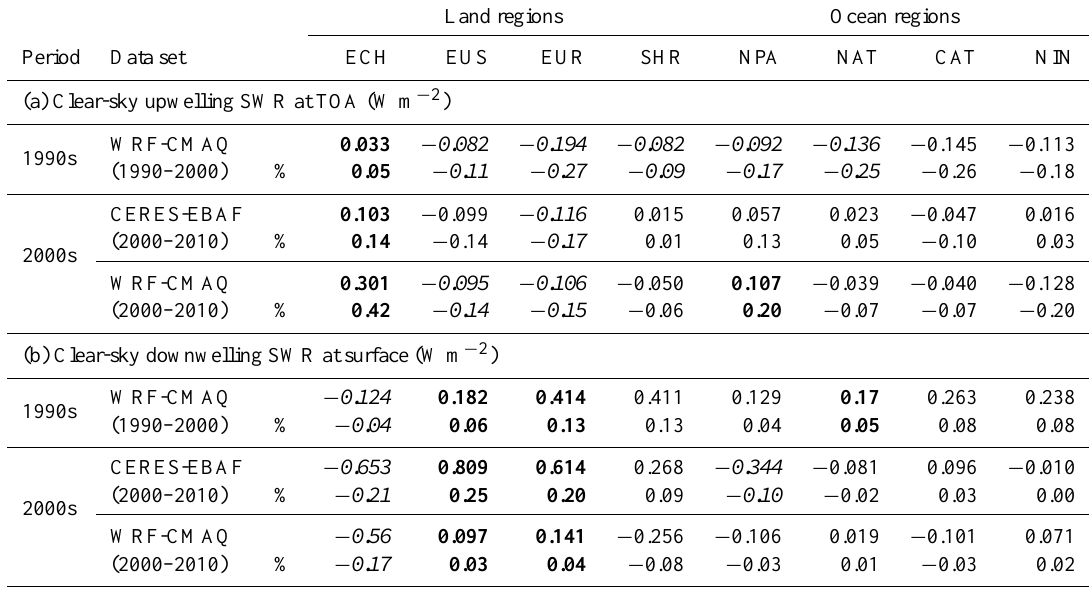
Table 3. Trends in regional SWR from satellite retrievals and WRF-CMAQ model. Land regions Ocean